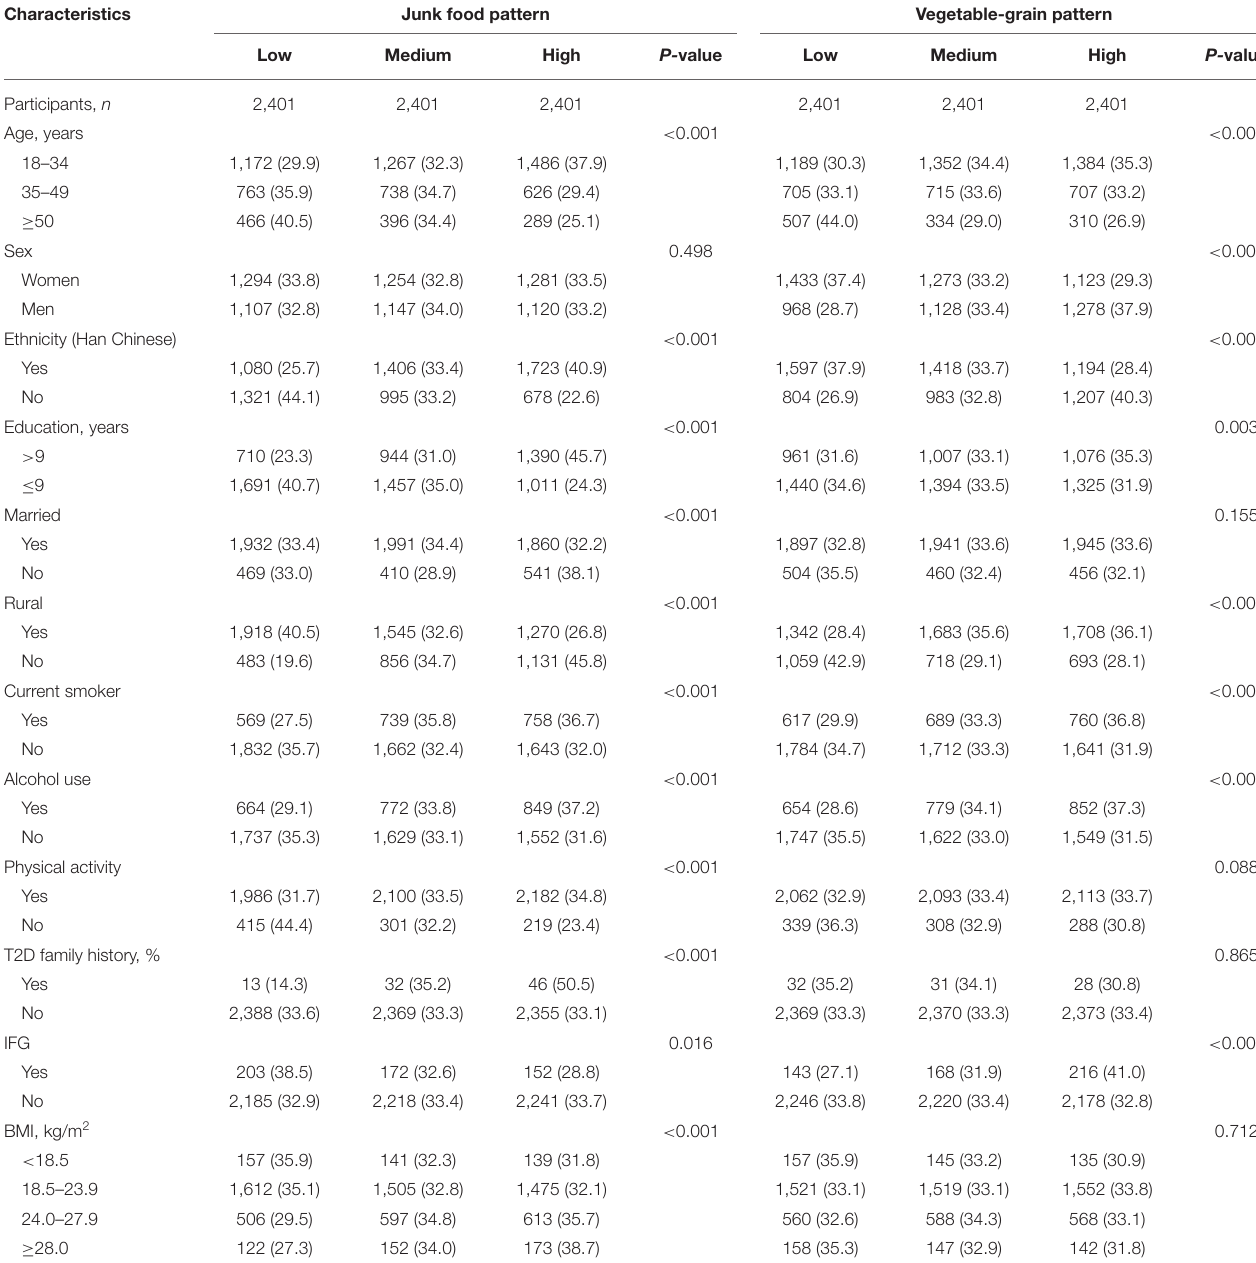
TABLE 2 | Tertiles of dietary patterns over subjects with different baseline characteristics in Southwest China (%). Characteristics Junk food pattern Vegetable-grain